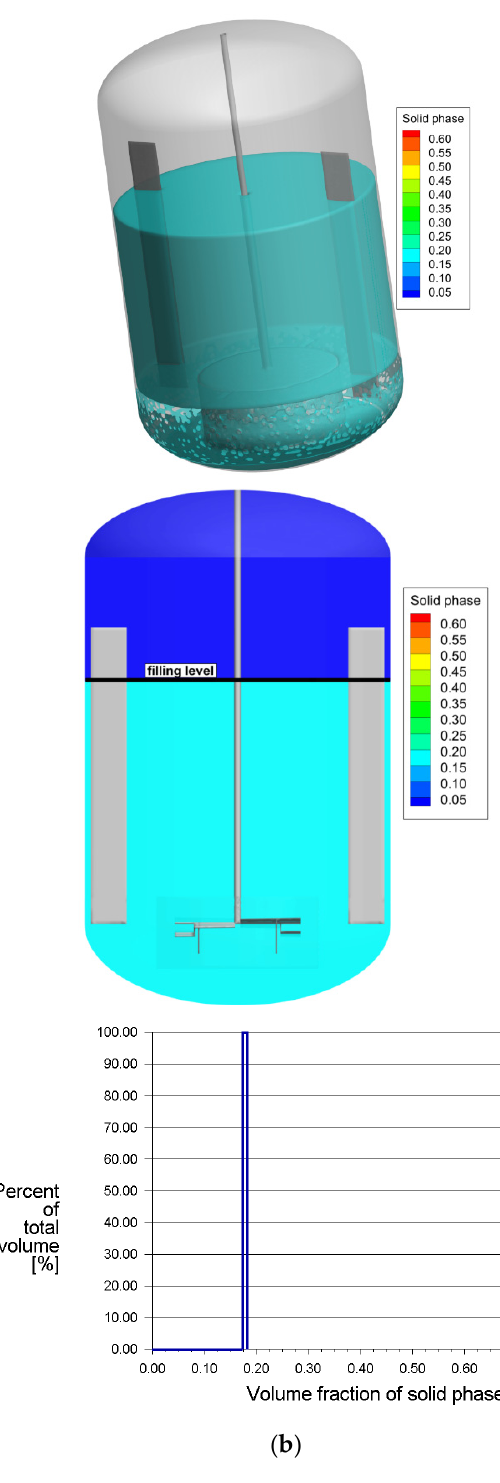
Figure 3. Initial state of the volume fraction distribution of the solid phase: ( a ) flow started from the solid phase fully sedimented; ( b ) flow started from the solid phase dispersed in the entire volume of liquid.